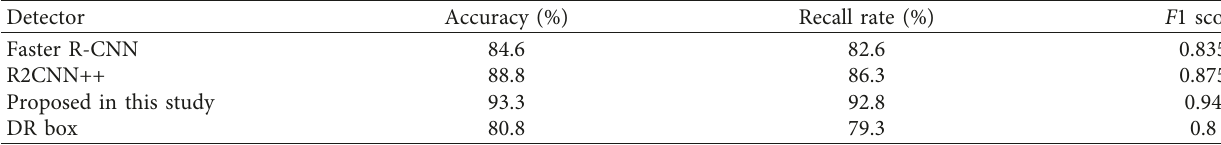
Table 11: Performance comparison experiment of the detector proposed in this study.